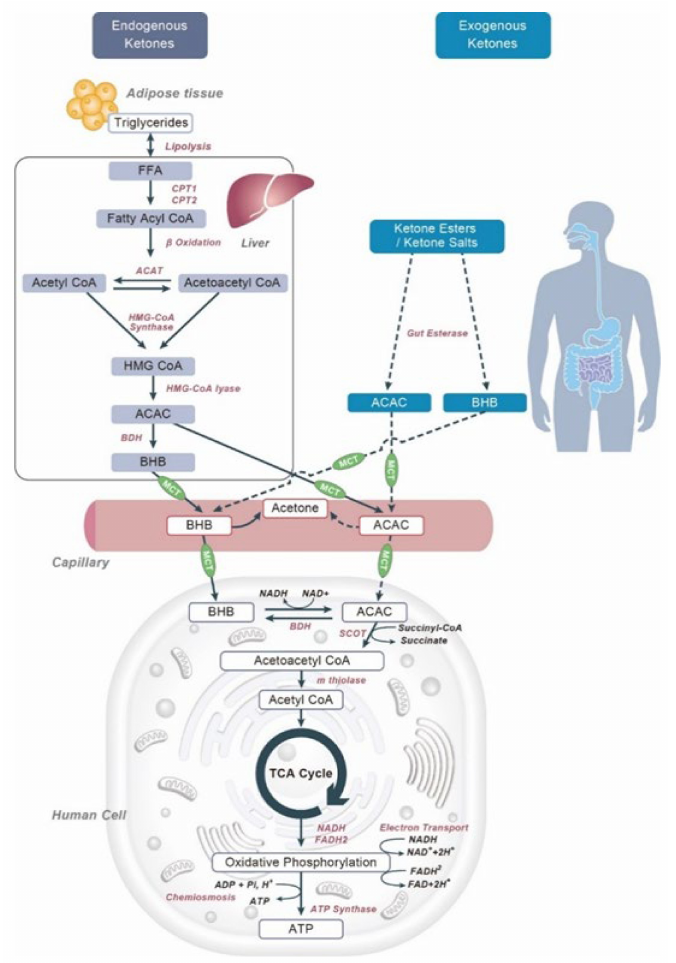
Figure 2. Endogenous and exogenous metabolic pathways. NAD: nicotinamide adenine dinu- cleotide; FADH: reduced flavin adenine dinucleotide; NADH: nicotinamide adenine dinucleotide (NAD) + hydrogen (H); CPT: carnitine palmitoyl transferase; ß HOB: beta hydroxybutyrate; BDH: D-3-hydroxybutyrate dehydrogenase; SCOT: succinyl-CoA acetoacetate transferase; AcAc: acetoac- etate; CoA: coenzyme A; ADP: adenosine diphosphate; ATP: adenosine triphosphate; Pi: phosphory- lated forms of phosphatidylinositol; H+: hydrogen ion; HMG-CoA: ß-hydroxy-ß-methylglutaryl-CoA; MCT: monocarboxylate